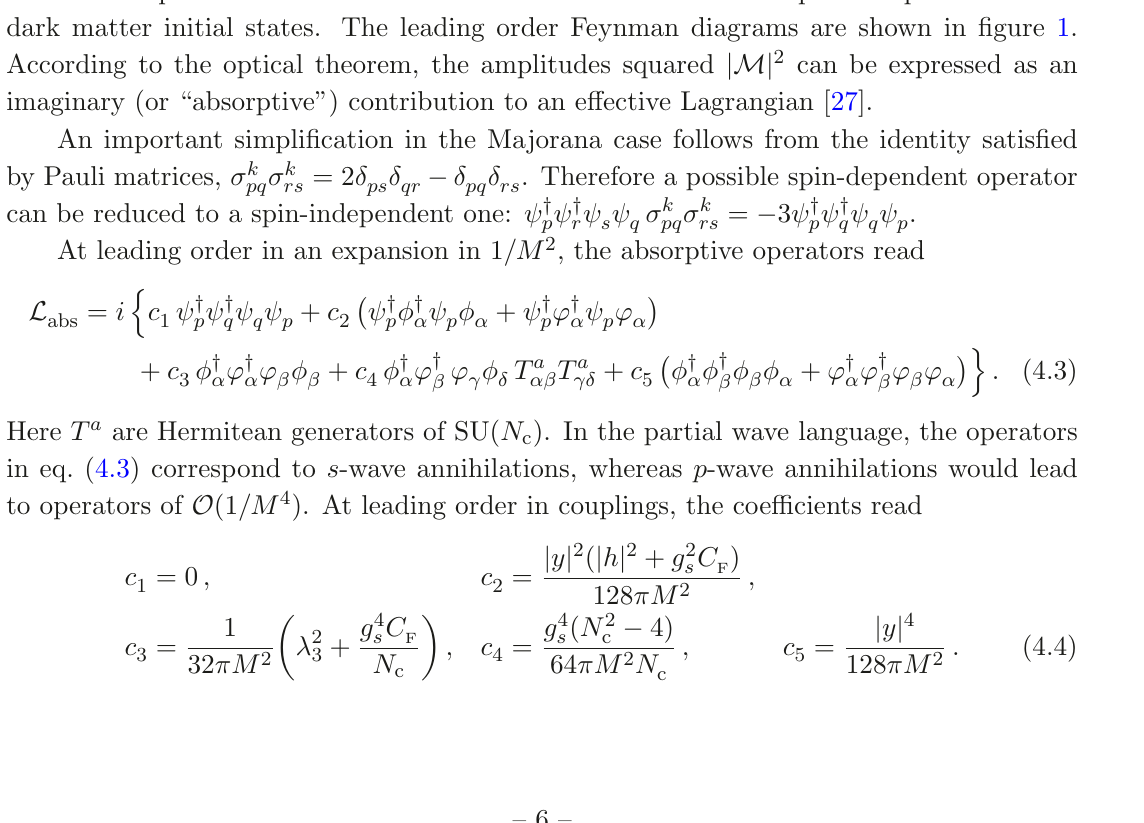
Figure 1 . 2 2 annihilation processes leading to the coefficients in eq. (4.4). Thick solid lines → stand for Majorana particles, thick dashed lines for coloured scalars, wiggly lines for gluons, arrowed lines for quarks, and thin dashed lines for Higgs bosons and longitudinal polarizations of W ± and Z 0